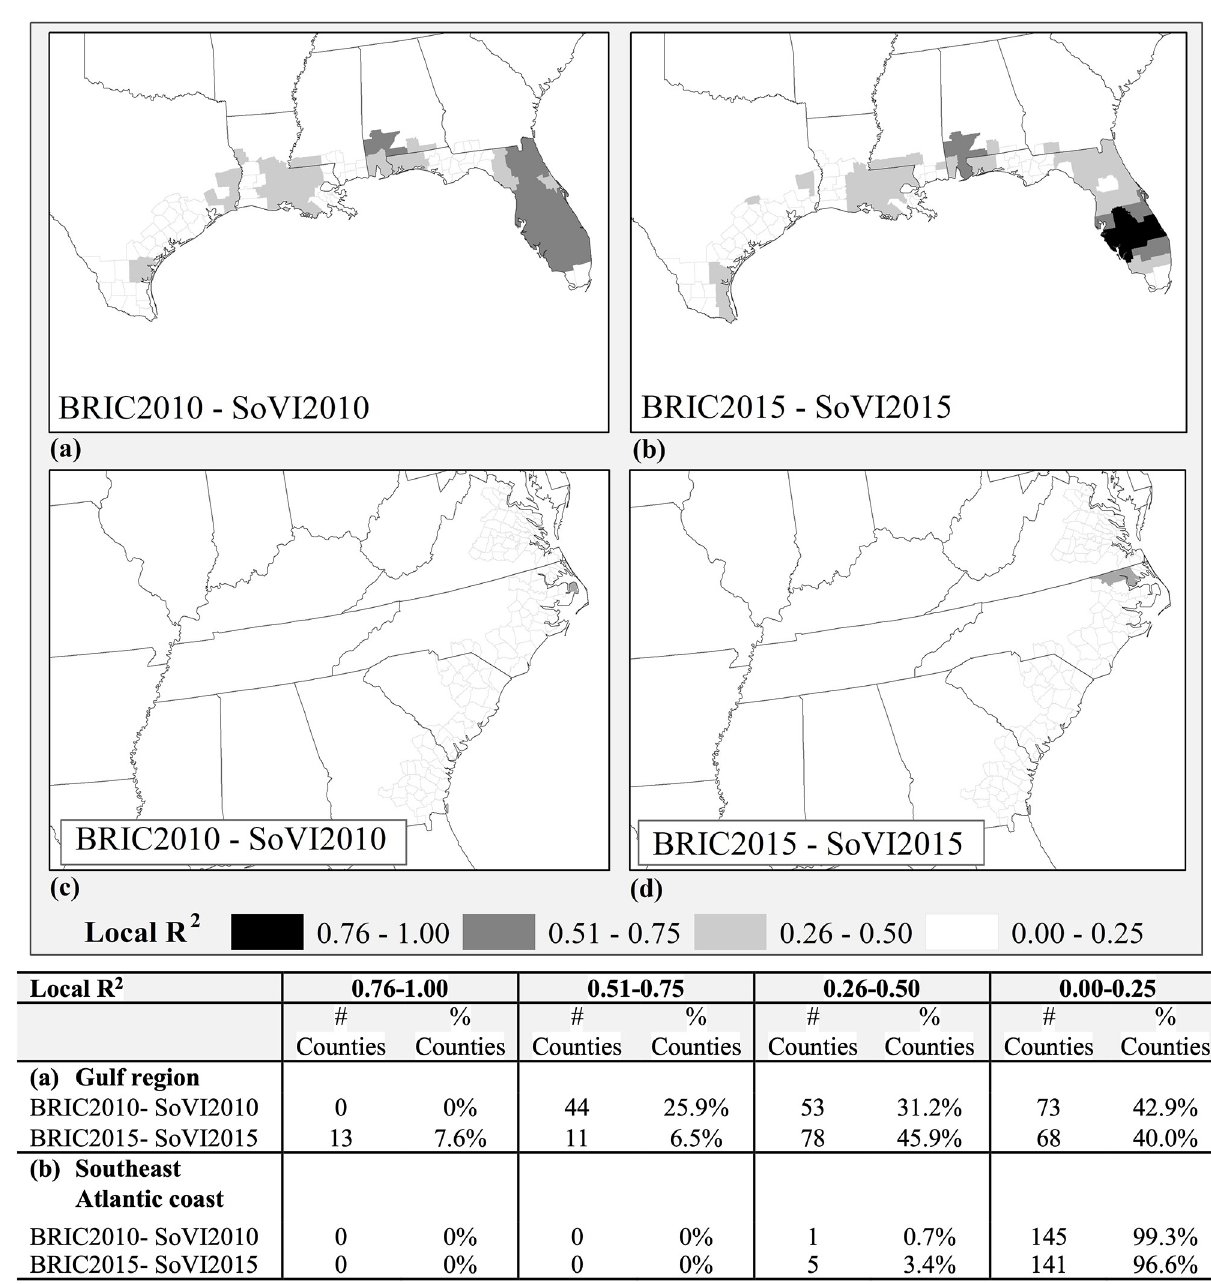
Fig 5. Local R 2 from GWR results for BRIC and SoVI (2010, 2015)—(a, b) Gulf region counties, (c, d) Southeast Atlantic coastal counties. County and state boundaries are retrieved from the U.S. Census Bureau (https://www.census.gov/geographies/mapping-files/time-series/geo/carto-boundary-